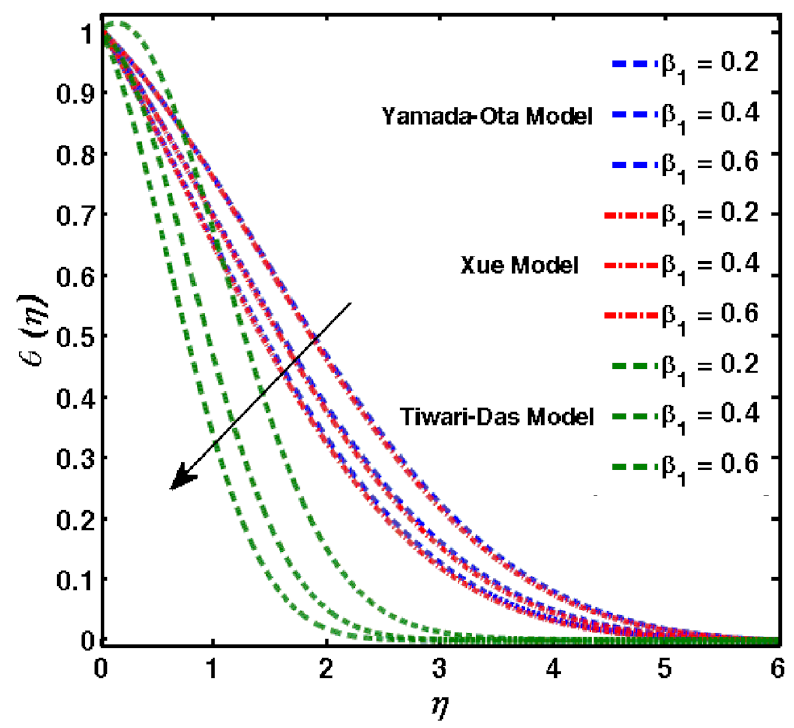
Figure 8. Influence of β 1 on θ ( η ) when λ = 0.0.